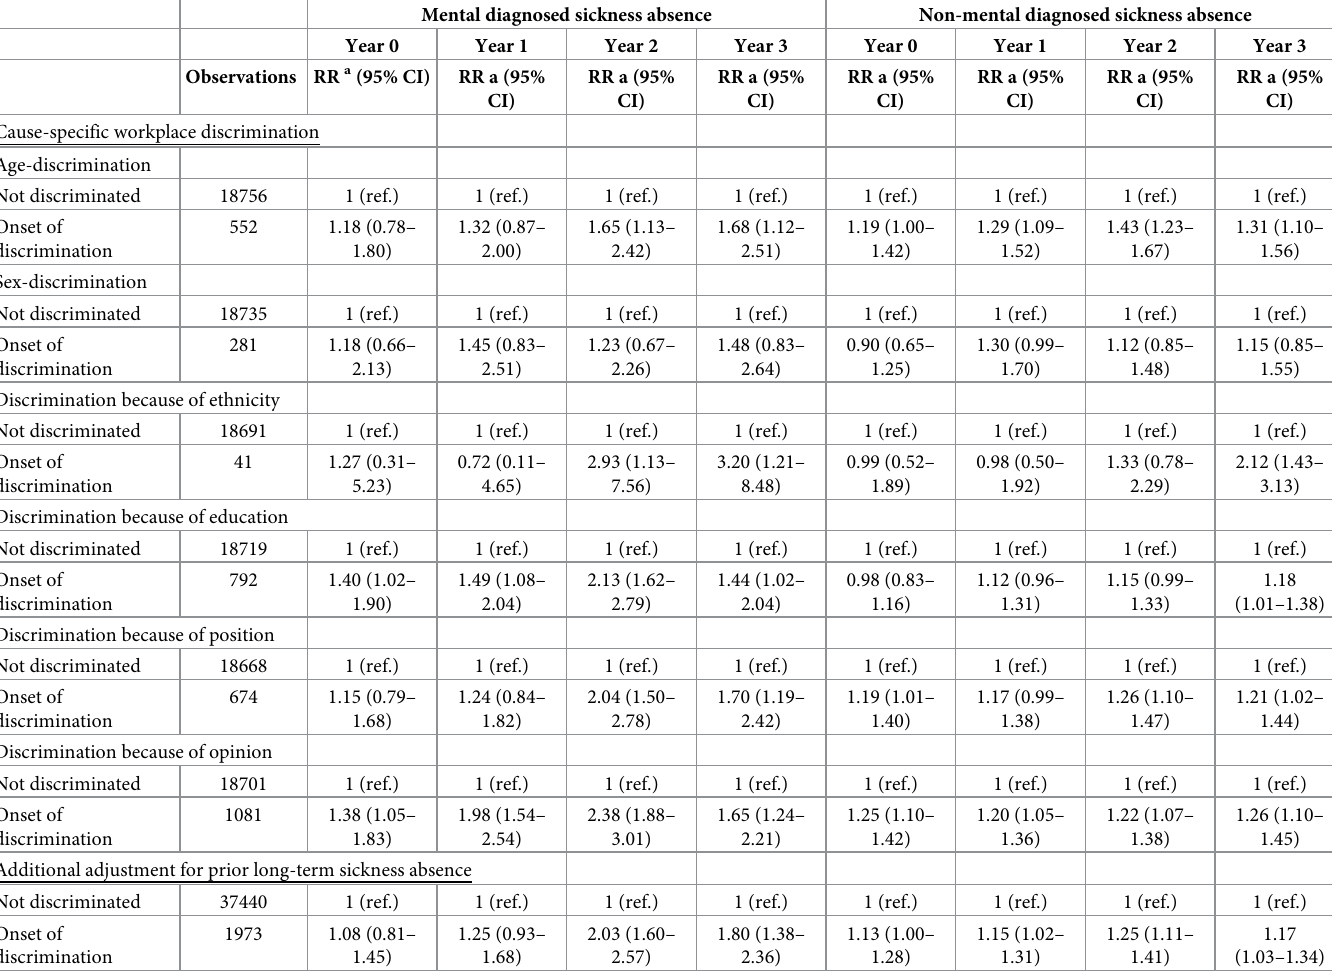
Table 3. Onset of cause-specific workplace discrimination and annual risk of mental and non-mental diagnosed long-term sickness